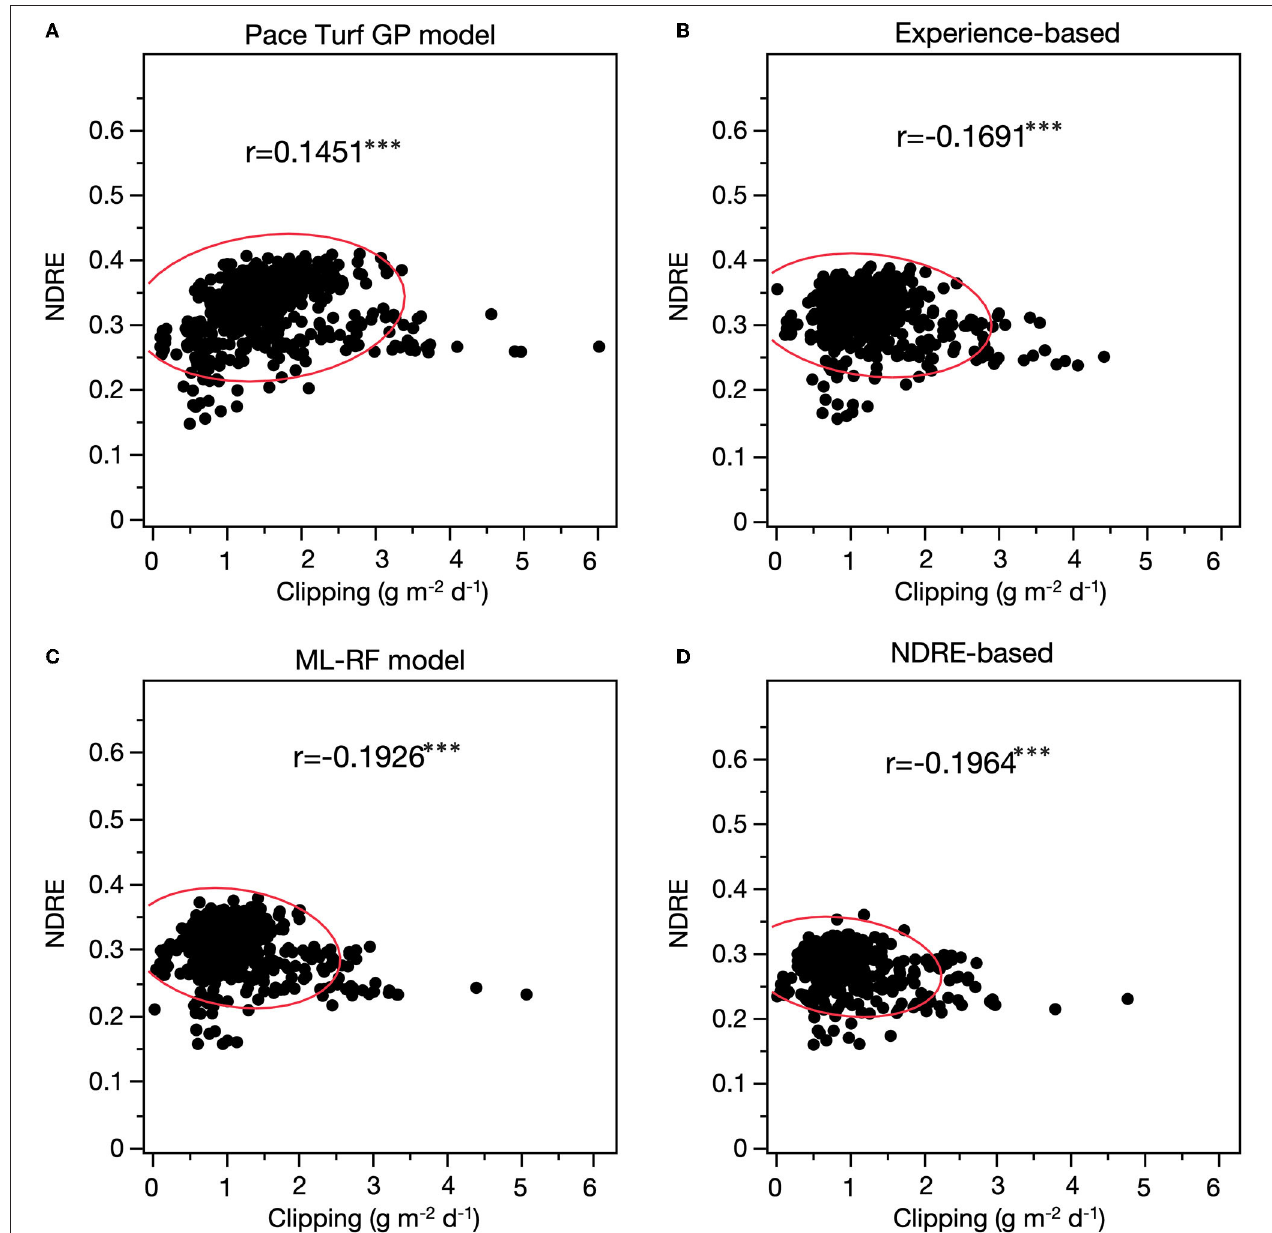
FIGURE 5 | Pearson correlation between vegetative index (NDRE) and corresponding creeping bentgrass clipping yield, where the turfgrass was fertilized using different strategies (A) . PACE Turf GP model: using the PACE Turf growth potential model; (B) experience-based: traditional N fertilization plan that is based on turfgrass quality and manager’s experience; (C) ML-RF model: machine learning-random forest growth prediction model; (D) NDRE-based: vegetative index (NDRE)-guided N fertilization. The red lines illustrate the 95%